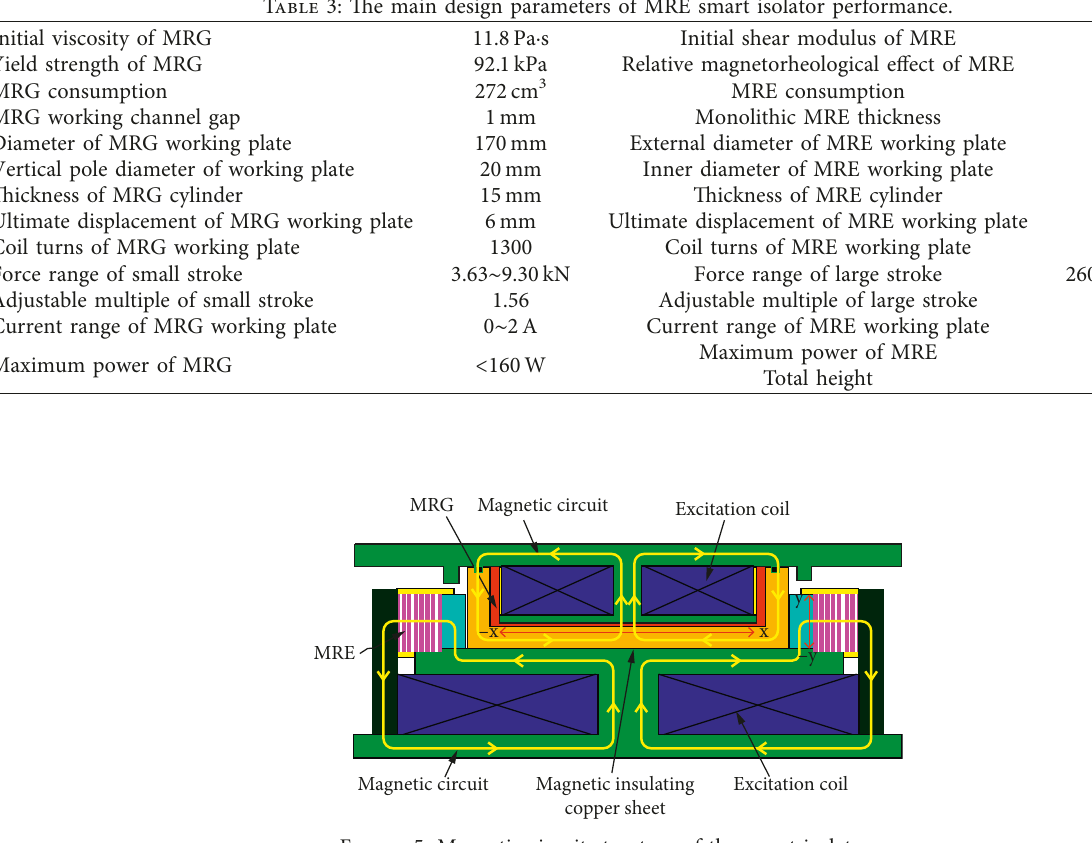
Figure 5: Magnetic circuit structure of the smart isolator.